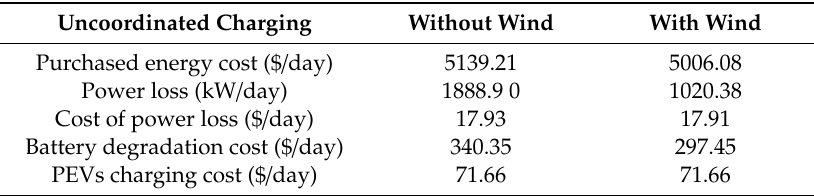
Table 3. Power loss and costs of uncoordinated charging approach.